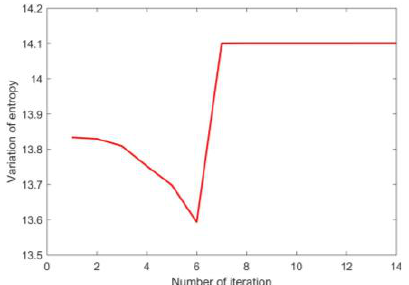
Figure 8. The entropy variation during successive iterations.